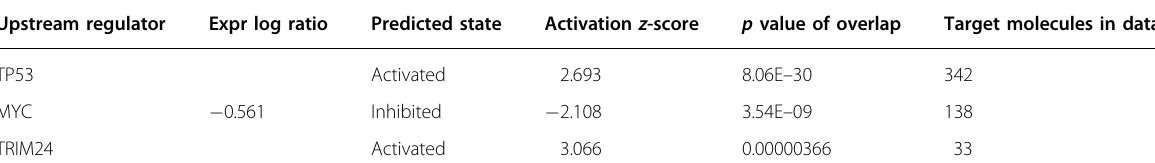
Table 3 List of the top 3 transcription factors projected by IPA Upstream Regulator